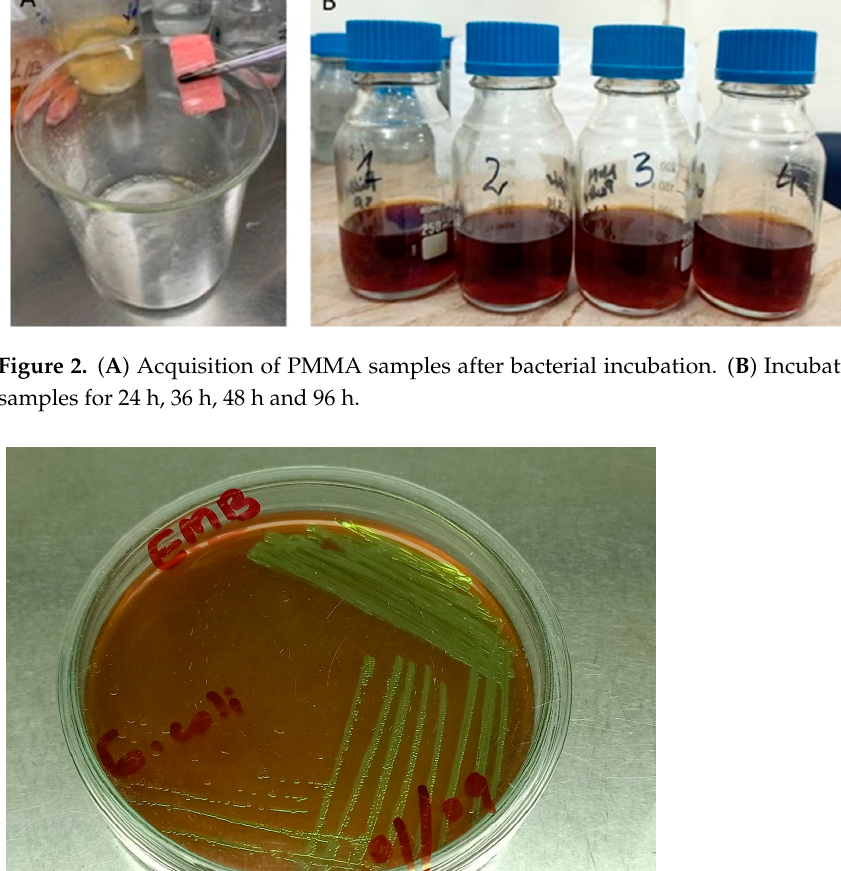
monitored and CFU were counted.